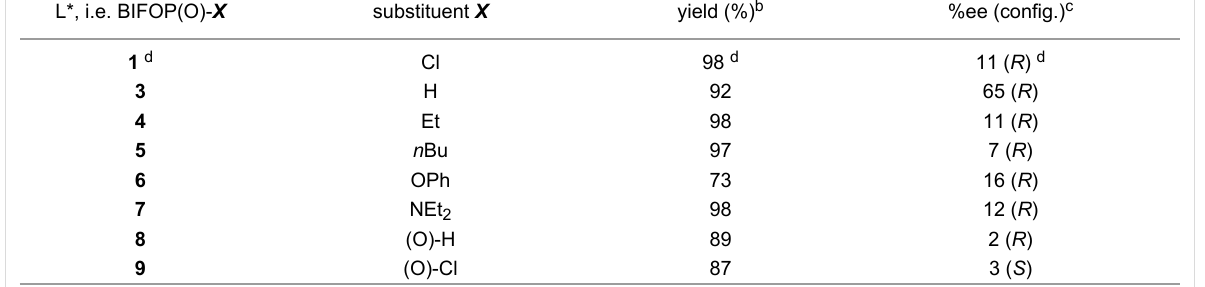
Table 3: Enantioselective Cu-catalyzed 1,4-additions of diethylzinc to 2-cyclohexen-1-one (cf. Scheme 5). a L*, i.e. BIFOP(O)-